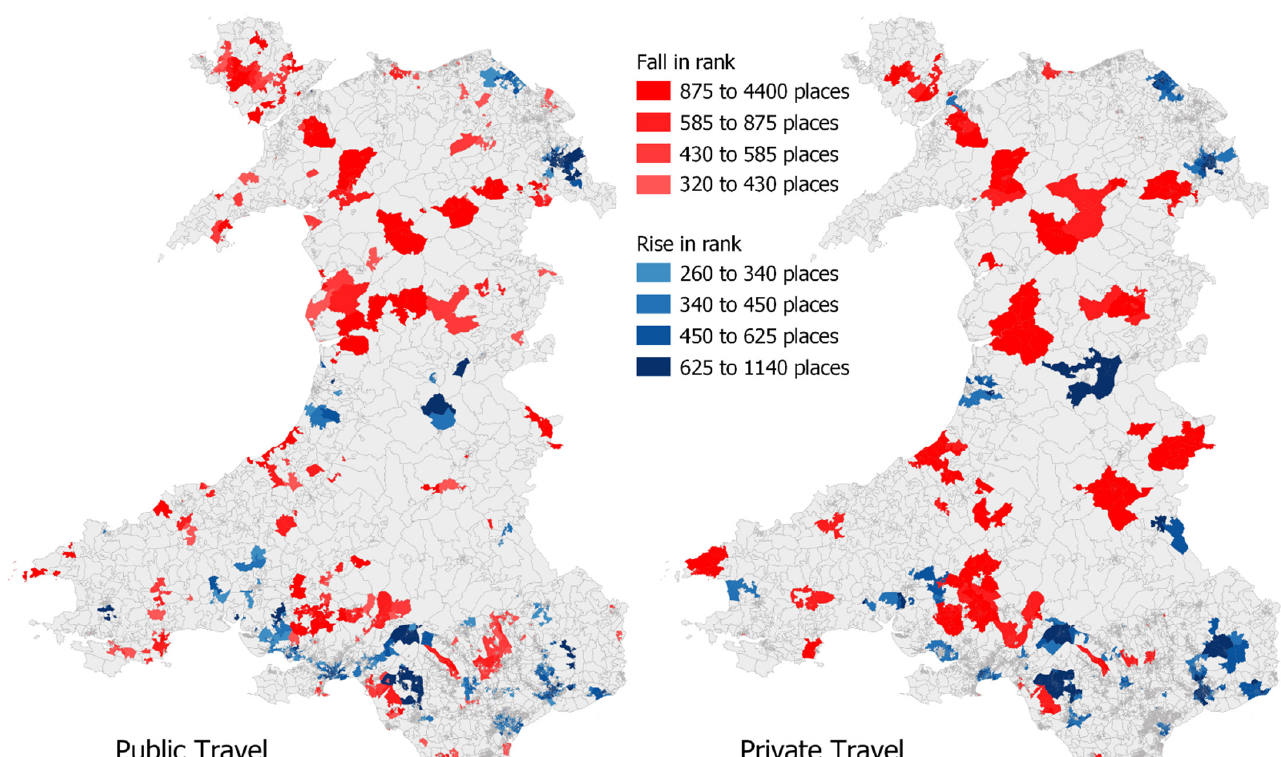
Figure 6. Difference in FCA score rankings between Model 1 and Model 2. A large fall (red) or rise (blue) in the ranking implies a notably lower or higher accessibility level, respectively, when branch operating hours are also taken into consideration.